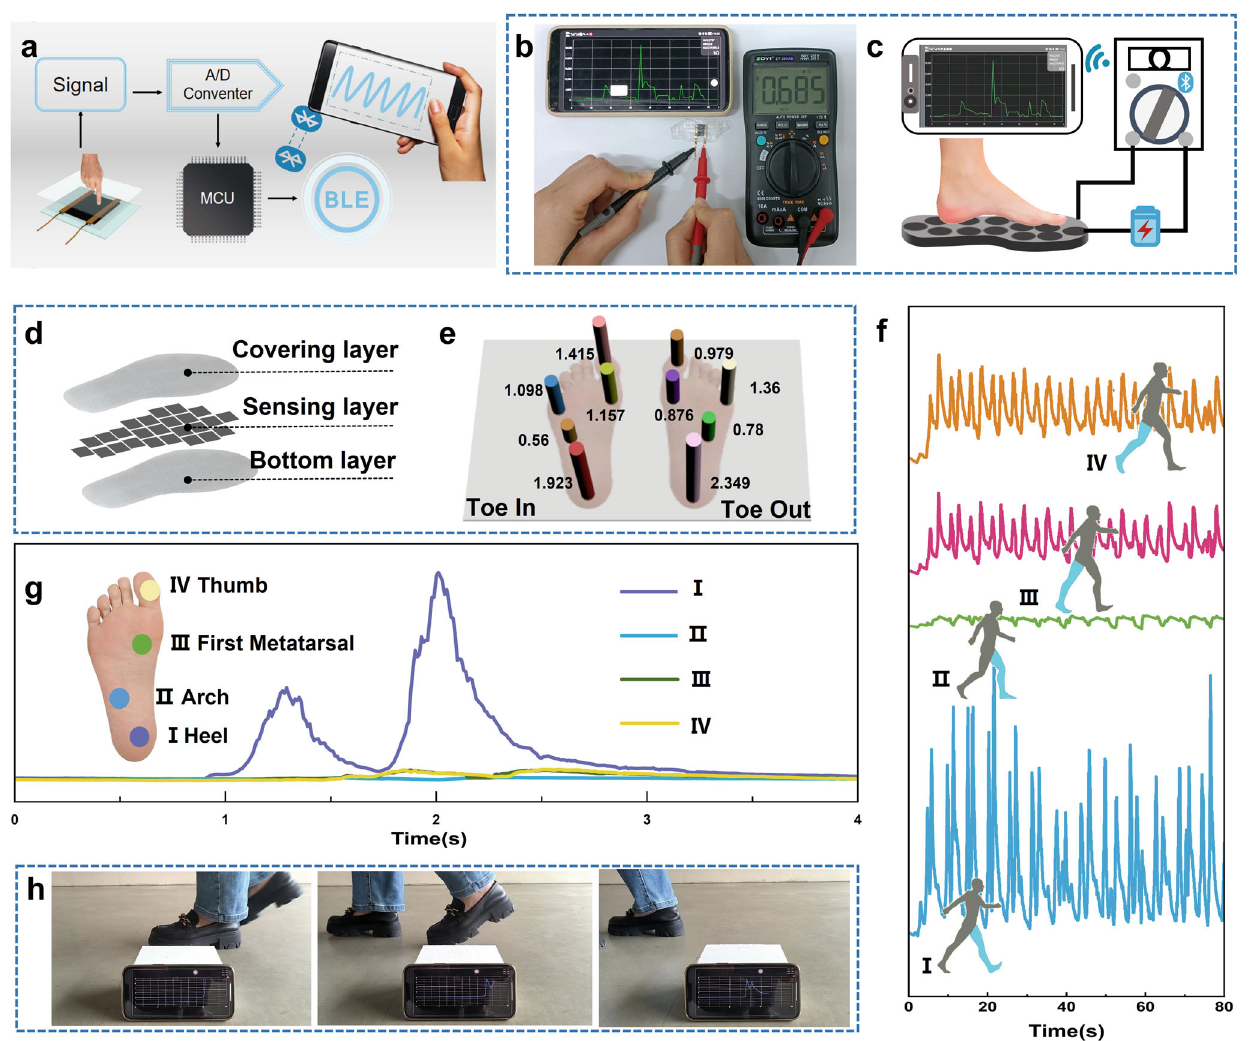
Fig. 9 Wireless real-time foot pressure mapping system. a Schematic diagram of the Bluetooth transmission mode. b Physical picture of the Bluetooth signal transmission of one single sensor. c Schematic diagram of a wireless smart insole based on a Bluetooth module. d Schematic diagram of the smart insole. e Histogram of Toe-in and Toe-out signals monitored by the smart insole ( fi ve detection points). f Signals of walking cycles measured at the four monitoring points. (From bottom to top are the heel, arch, fi rst metatarsal and thumb). g Signals of one walking cycle. h Digital images of wireless smart insoles for one walk